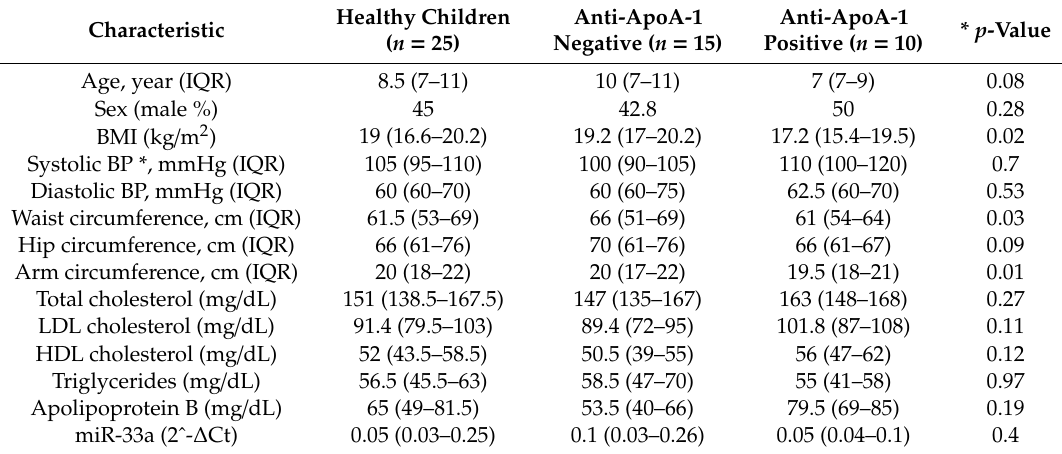
Table 2. Baseline demographic and biological characteristics of FH children according to anti-ApoA-1 IgG status.